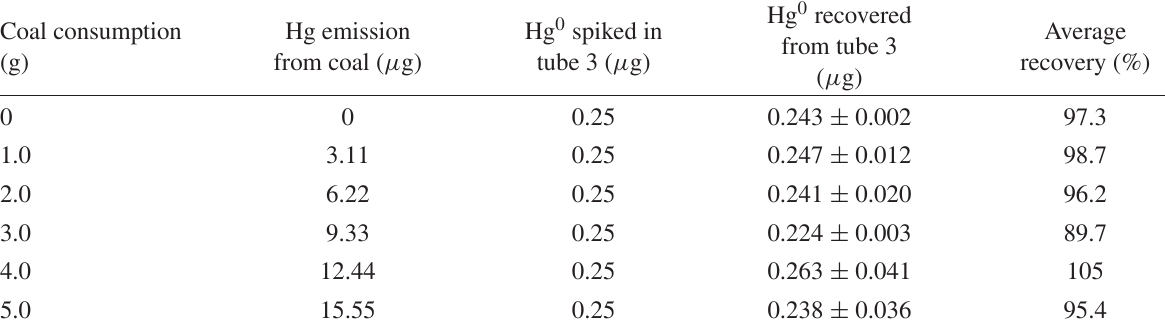
TABLE 3: Recovery of spiked Hg 0 in tube 3 in lab test ( n = 3